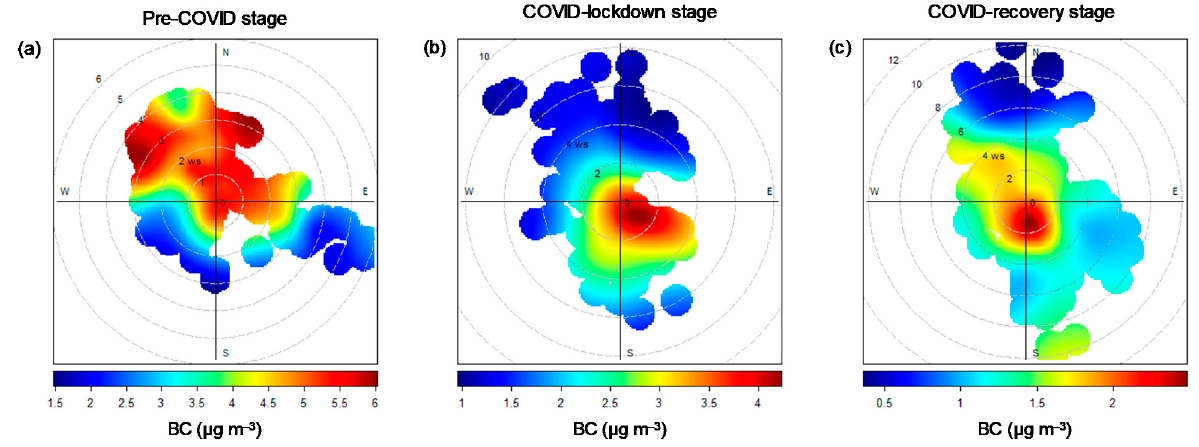
Figure 11. Bivariate polar plots for hourly BC mass concentration in three stages: (a) Pre-COVOD stage, (b) COVID-lockdown stage, and (c) COVID-recovery stage, respectively.